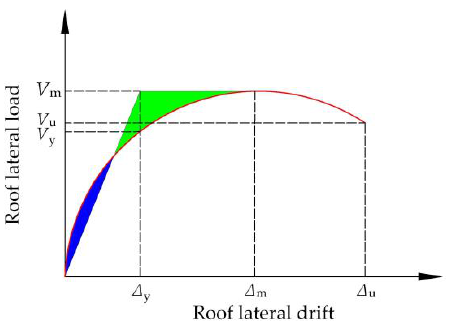
Figure 19. Method of determining yield point.